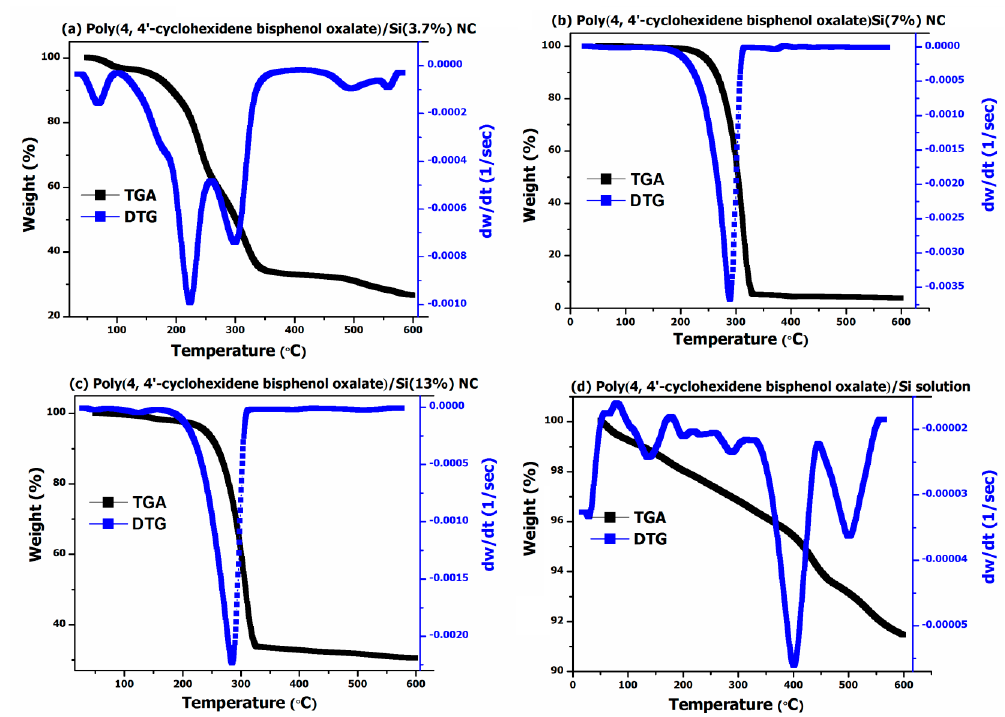
Figure 4. TGA and DTG analysis for poly(4,4’-cyclohexylidene bisphenol oxalate)/Si NCs: ( a ) poly(4,4’-cyclohexylidene bisphenol oxalate)/Si(3.7%), ( b ) poly(4,4’-cyclohexylidene bisphenol oxalate)/Si(7%), ( c ) poly(4,4’-cyclohexylidene bisphenol oxalate)/Si(13%) NC, and ( d ) poly(4,4’-cyclohexylidene bisphenol oxalate)/Si solution mixture. The poly(4,4’-cyclohexylidene bisphenol oxalate)/Si NCs characterized by the SEM analysis are